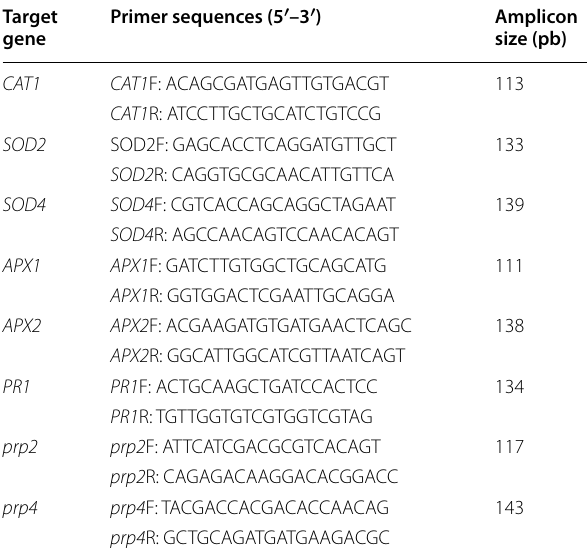
Table 1 Primers sequences used in the RT-qPCR analyses and sizes of the PCR products obtained Target Primer sequences (5 ′ –3 ′ gene